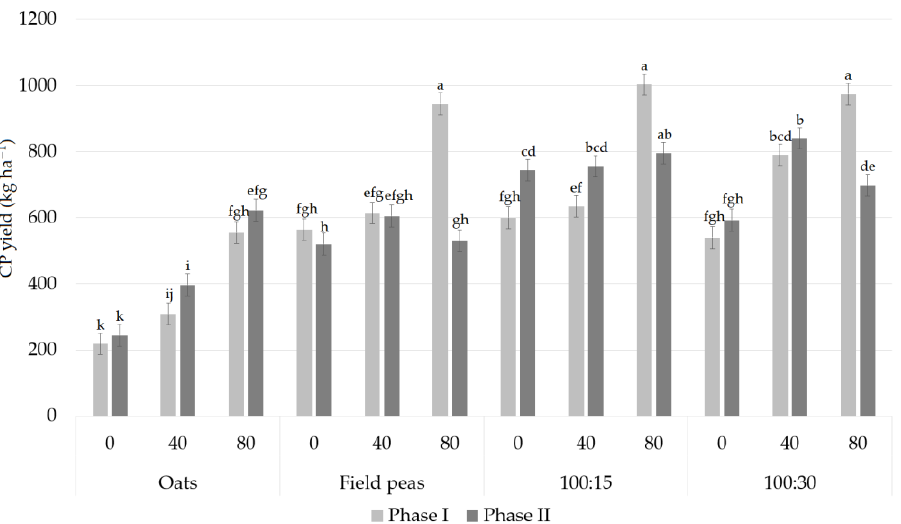
Figure 5. Crude protein yield of sole crops and their mixture under nitrogen fertilizer (0 kg ha −1 , 40 kg ha −1 , 80 kg ha −1 ) and two mowing phases (2017); error bars — standard error; a – k — significant dif- ferences between different treatments, a representing the highest value, etc.